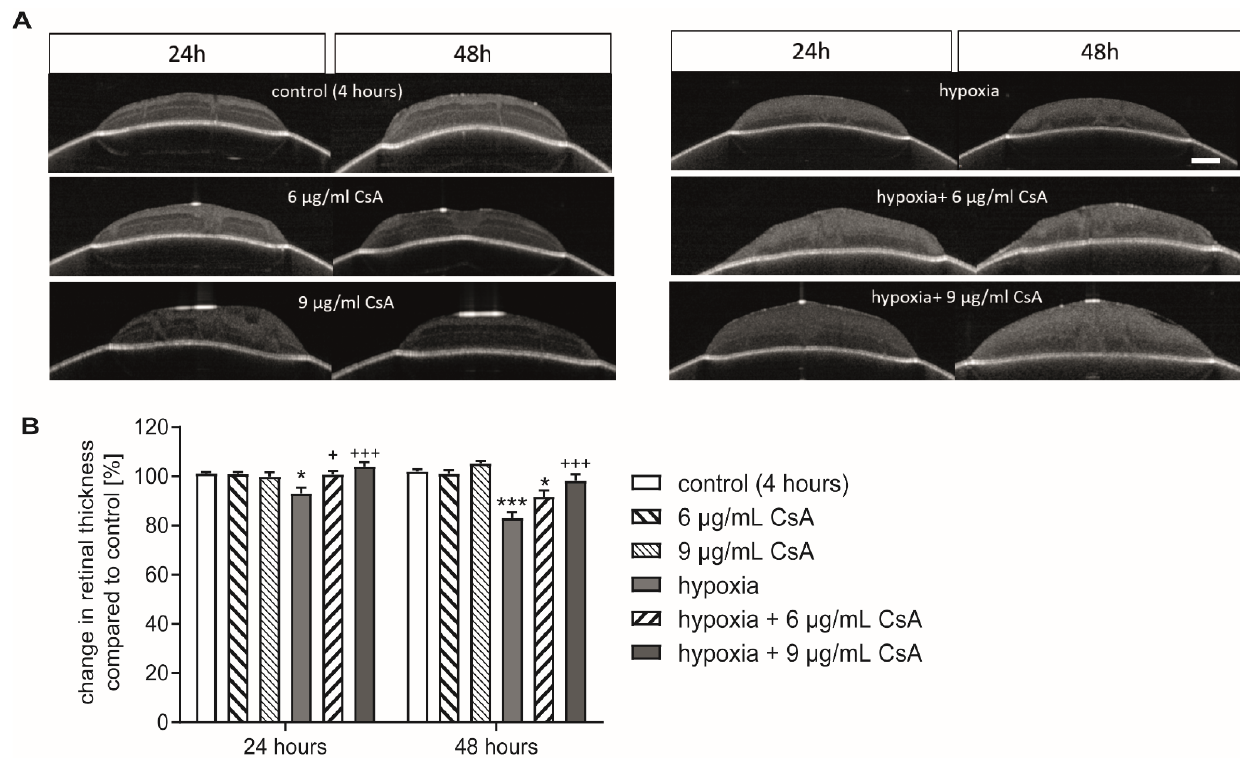
Figure 3. CsA protected against loss in retinal thickness. ( A ) Representative pictures of the OCT scans after 24 and 48 h. With the first measurement the position of the membrane insert was marked, and infrared images were taken shortly before the OCT scans to ensure identical positioning of the insert in the two consecutive measurements. Retinal thickness was measured at five equally distributed measuring points. Scale bar = 200 μ m. ( B ) Bar graph represents the change in retinal thickness at the 24 h or 48 h time points compared to the measurement at the 4 h time point, which is set as control. Bars and error bars indicate mean + SEM, n = 5 for all treatment groups. Significance is indicated as * with respect to the control condition and as + with respect to the ischemic treatment using the following significance levels: +/* p < 0.05, +++/*** p < 0.001.